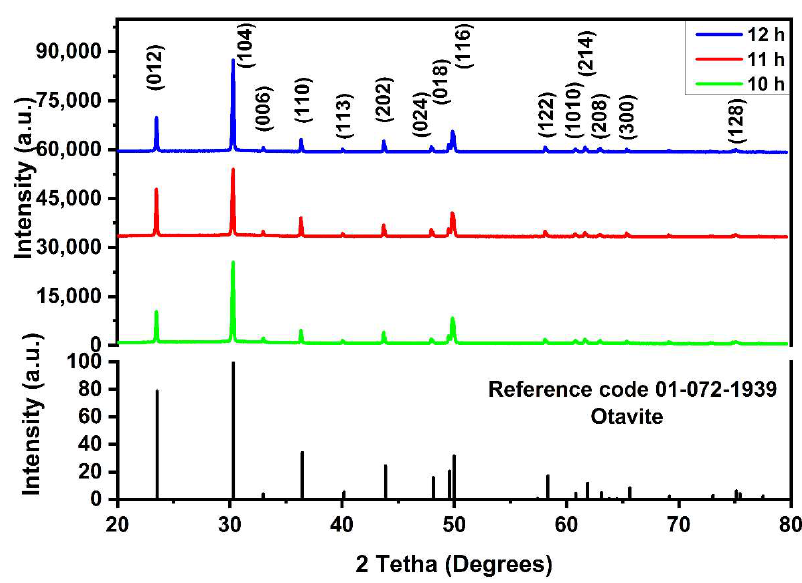
Figure 1. XRD diffractograms of the CdCO 3 samples deposited at 10, 11, and 12 h.